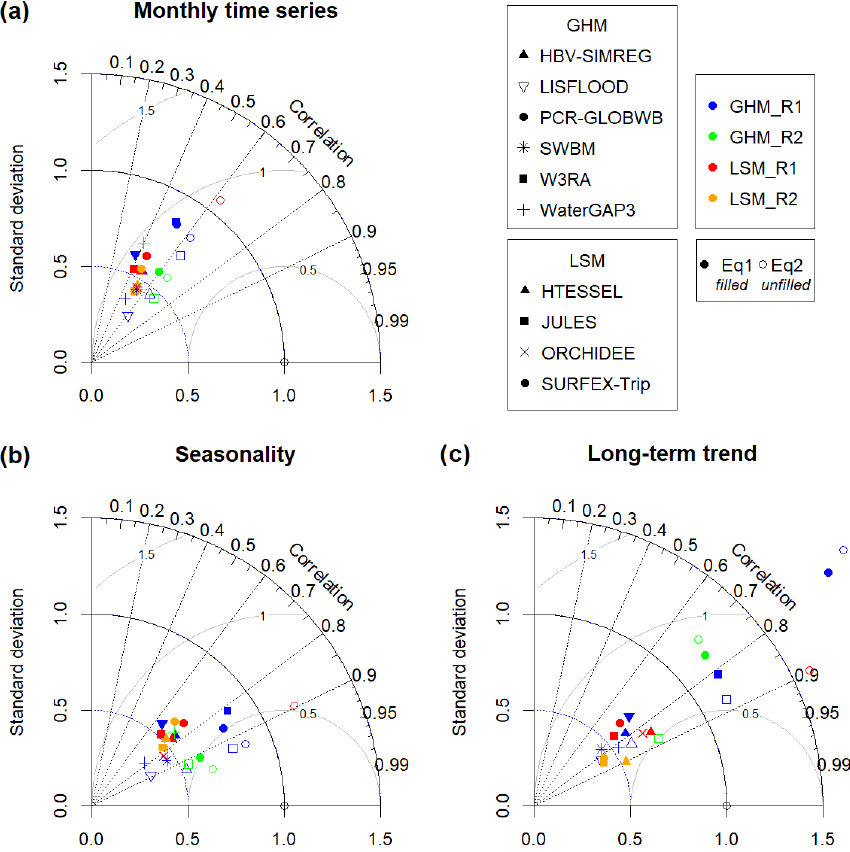
Figure 2. Taylor diagrams between each model output and GRACE data for the Magdalena river basin for (a) monthly time series, (b) seasonality, and (c) long-term trends. Models from the first reanalysis WRR1 are denoted as R1, and R2 denotes the second reanalysis WRR2.